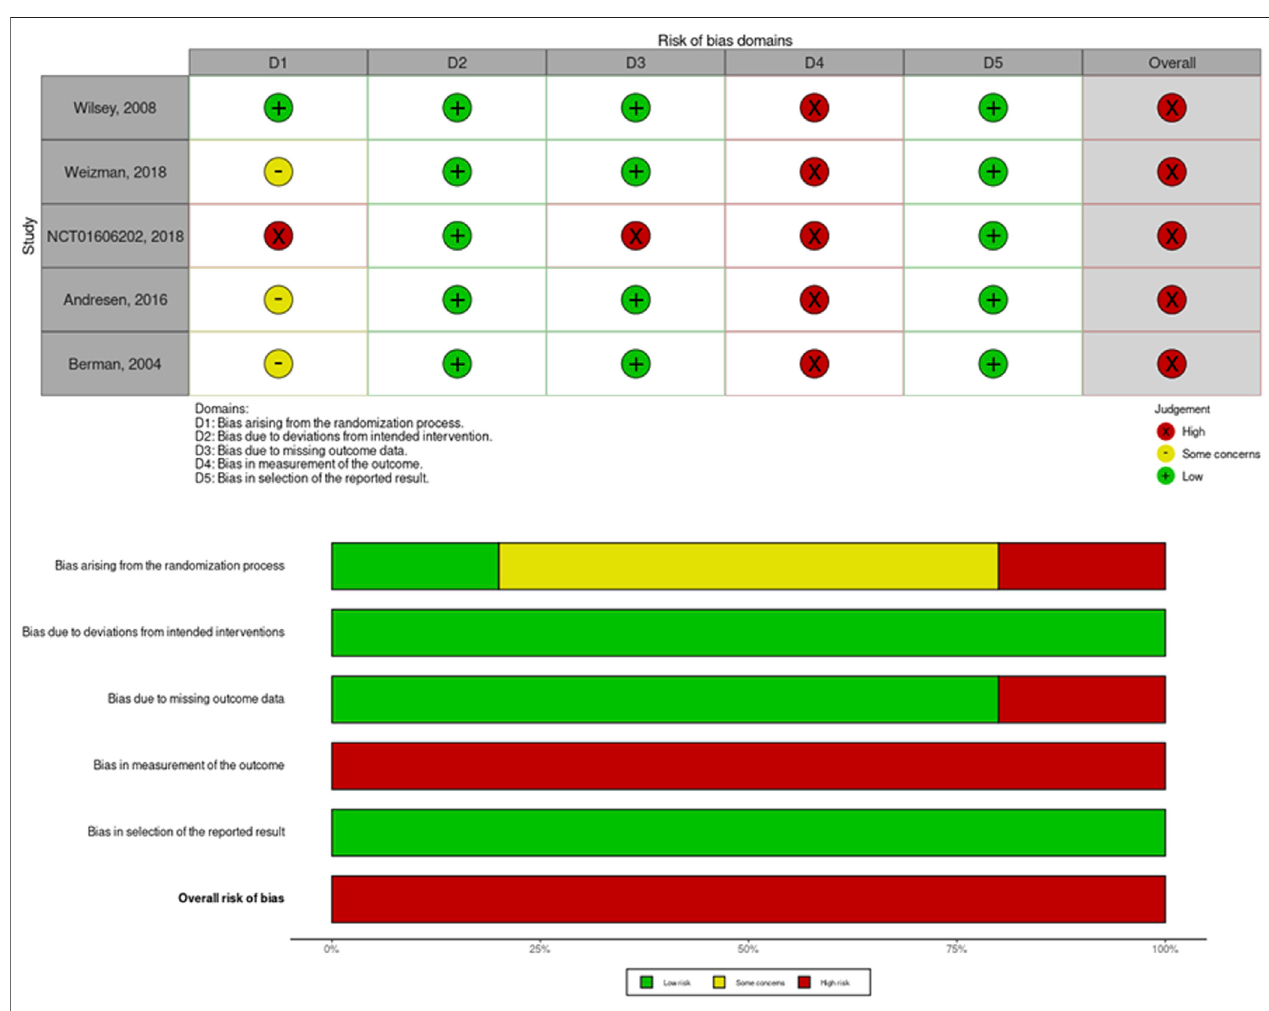
FIGURE 3 | ROB2, assessment of risk of bias in the included studies and the summary of domains.